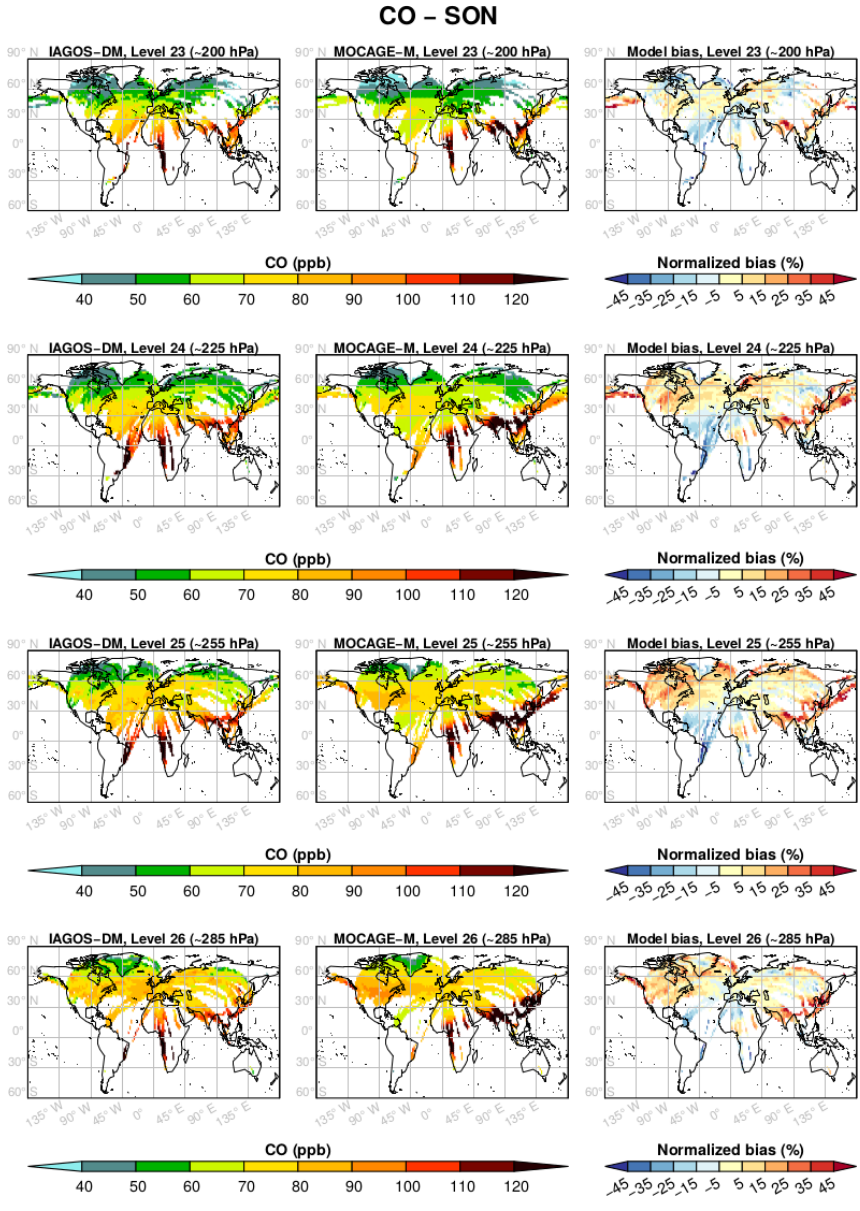
Figure A8. As Fig. 4 for boreal